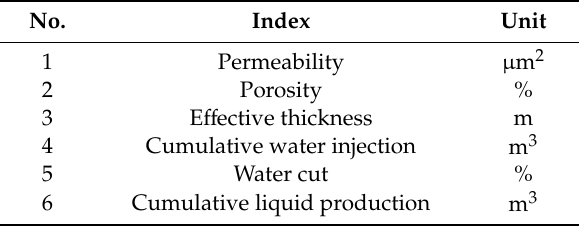
Table 4. Evaluation index system.